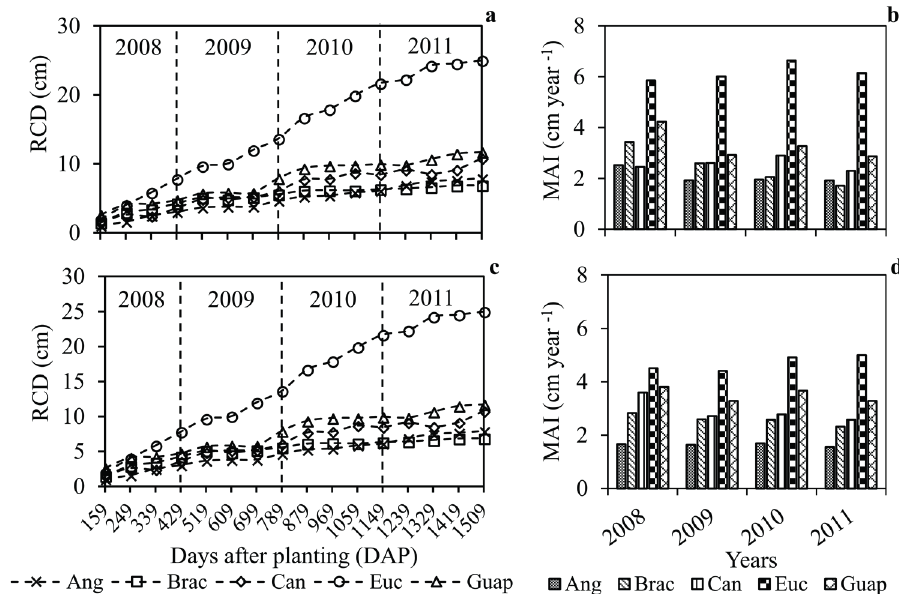
Figure 3 - Growth and mean annual increment (MAI) of root collar diameter (RCD) of tree species angico (Ang), bracatinga (Brac), canafístula (Can), eucalyptus (Euc) and guapuruvu (Guap) in agroforestry systems strip ( a and b ) and line ( c and d ), from 159 to 1509 days after planting (DAP) of the seedlings in Frederico Westphalen -